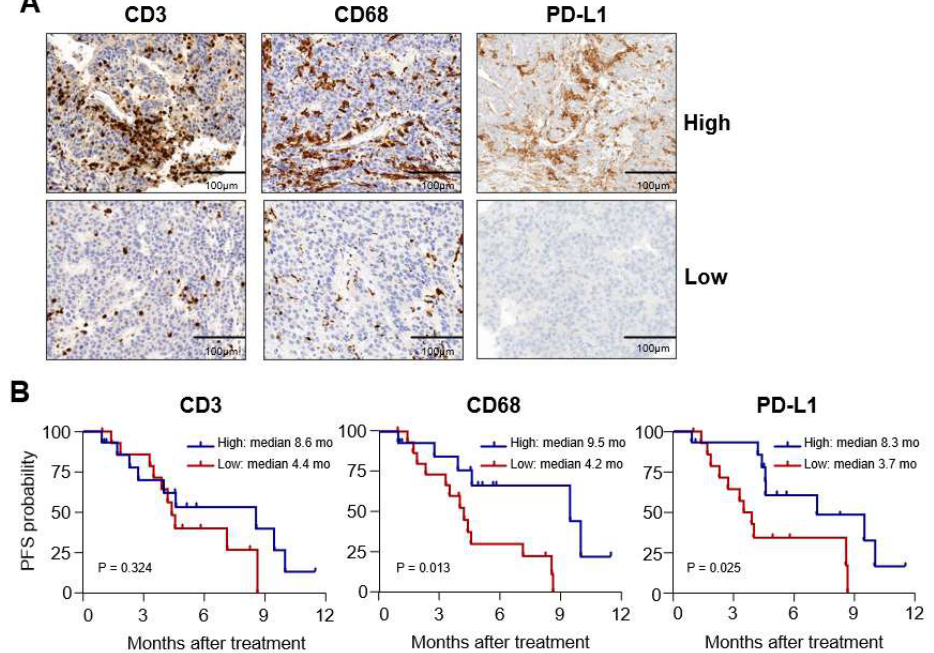
Figure 1. Differences in progression-free survival (PFS) according to the expression of immunologic markers. ( A ) Representative immunohistochemistry findings for CD3, CD68, and programmed cell death-ligand-1 (PD-L1) in hepatocellular carcinoma (HCC) biopsy samples. ( B ) Kaplan–Meier curves showing PFS in high and low subgroups determined by median cell counts of each marker (as shown).